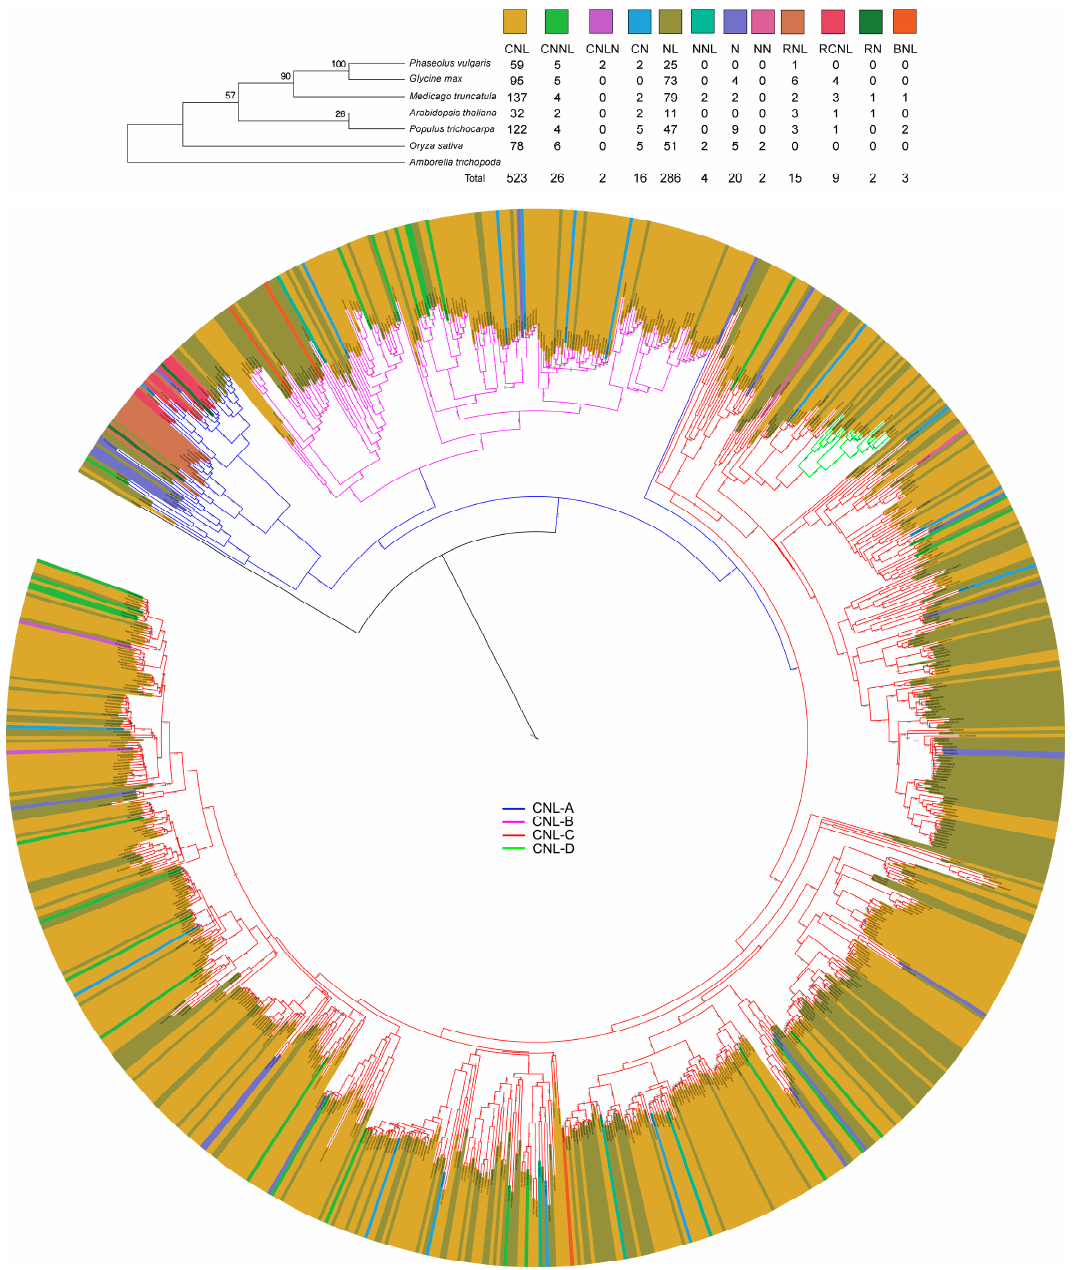
Figure 1. Maximum-likelihood tree of the six plant species ( A. thaliana O. sativa , M. truncatula , P. vulgaris , P. trichocarpa , and G. max ) based on rbc L gene sequences: the values on the branches represent bootstrap support of 1000 replicates ( upper left ). Diversity of nTNL genes across the genomes from six species: classification of the 12 subgroups was based on the presence of coil, NBS, LRR (Lxx), RPW8, and BED zinc finger domain ( upper right ). Maximum-likelihood tree of the identified nTNL NBS-LRR proteins from six plant species; on the branches are the bootstrap support of 100 replicates (lower middle). Altogether 908 protein sequences were included, using the Streptomyces outgroup P25941 (GI: 19857619). Tree branches are color-coded: blue, pink, red, and green for CNL-A, CNL-B, CNL-C, and CNL-D, respectively. The phylogenetic tree was visualized using Interactive tree of life (iTOL) v3. The nTNL gene accessions are color-coded creating a band of 12 colors, exterior to the gene accession names. Branch lengths of 11 sequences (LOC_Os11g42090, LOC_Os11g42070, LOC_Os04g41370, Medtr5g028420, Medtr5g028750, Medtr5g028290, Medtr5g028340, Glyma20g33531, Glyma20g33740, AT5G66910, and AT5G66900) were collapsed to their respective clades to accommodate band size around the tree.